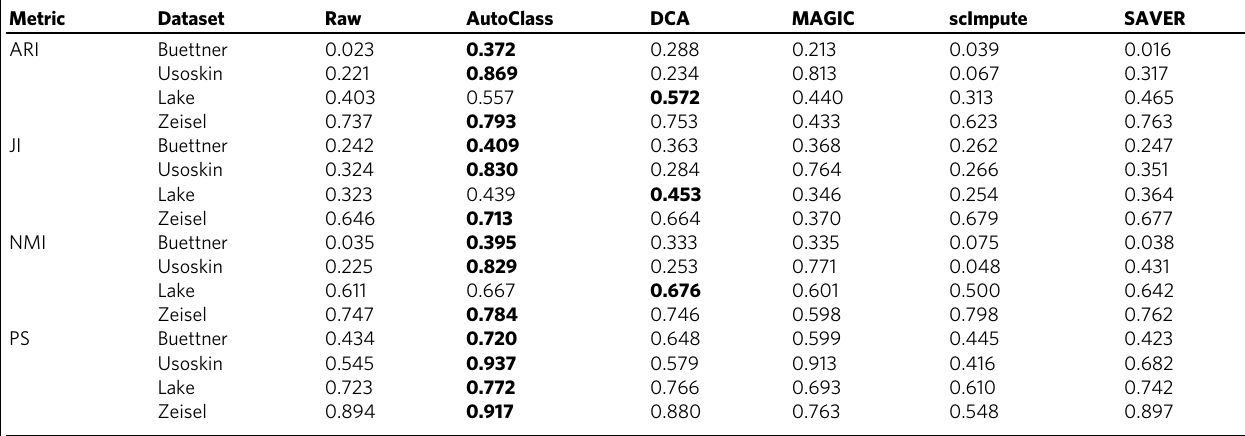
Table 1 Evaluation of clustering results of four real scRNA-Seq datasets. Metric